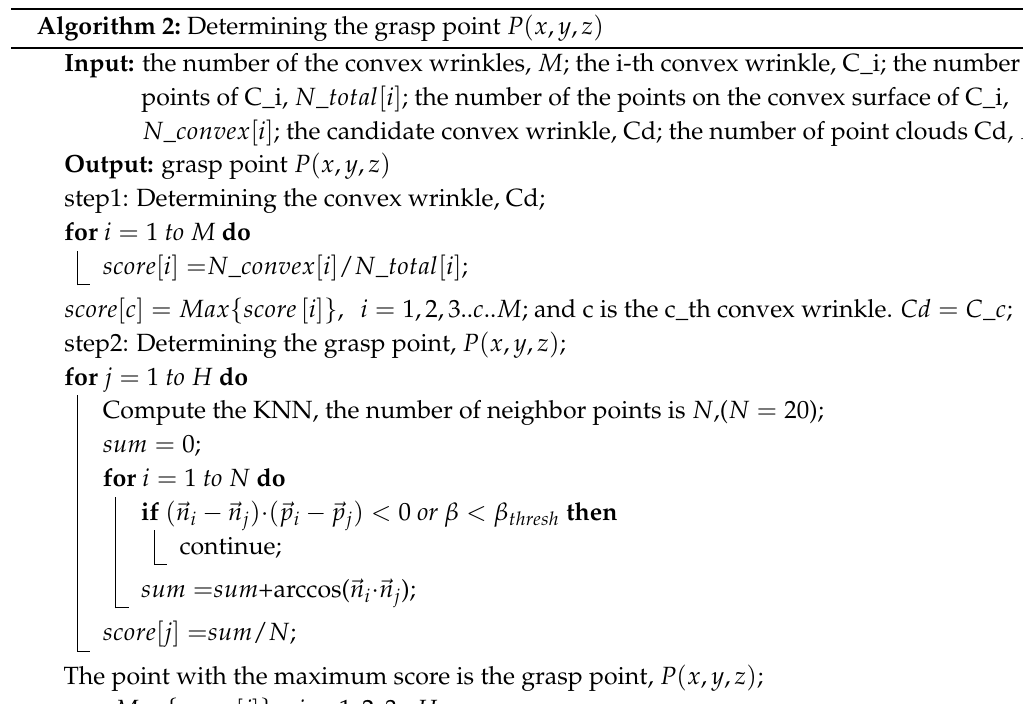
Algorithm 2: Determining the grasp point P ( x , y , z